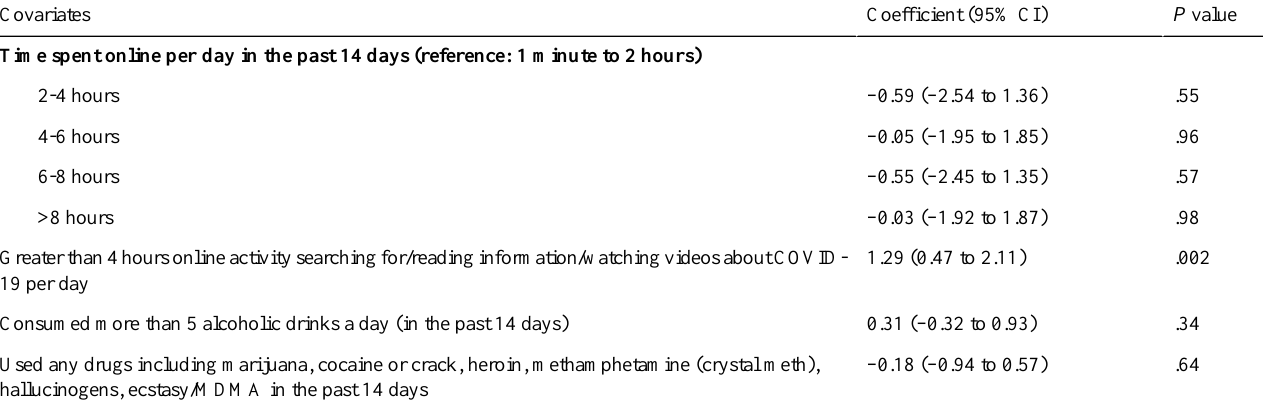
Table 2. Multivariate linear regression results predicting Generalized Anxiety Disorder 7 score as a function of key covariates. Time spent online per day in the past 14 days (reference: 1 minute to 2